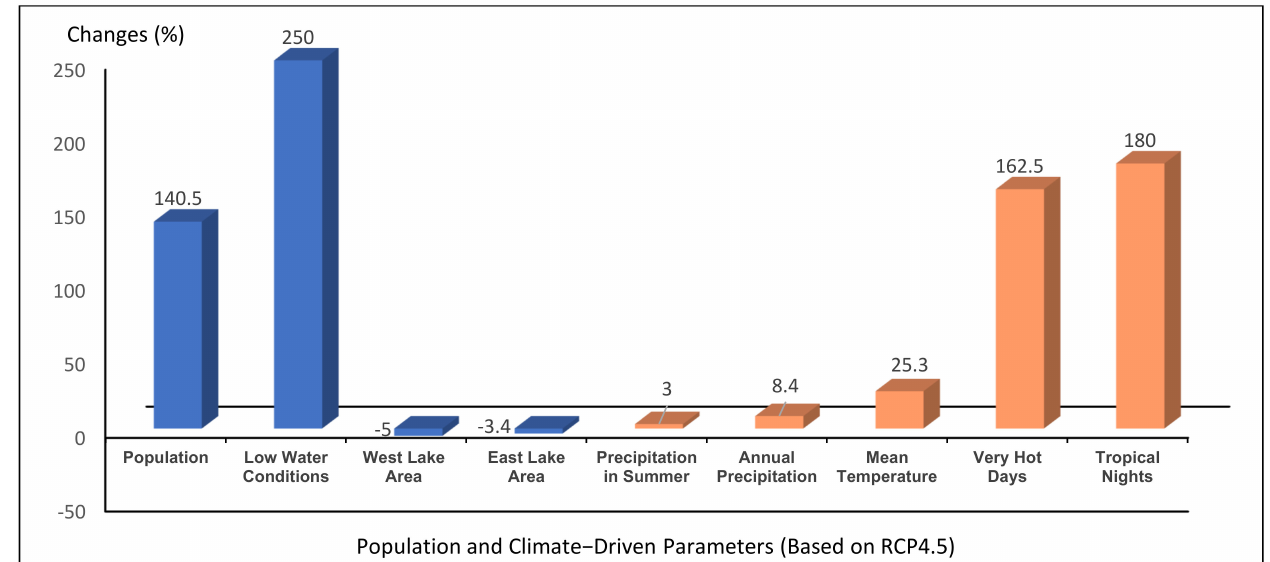
Figure 19. Changes in population and climate-driven parameters in the study area (blue represents observed data and light orange refers to future projections for 2080).